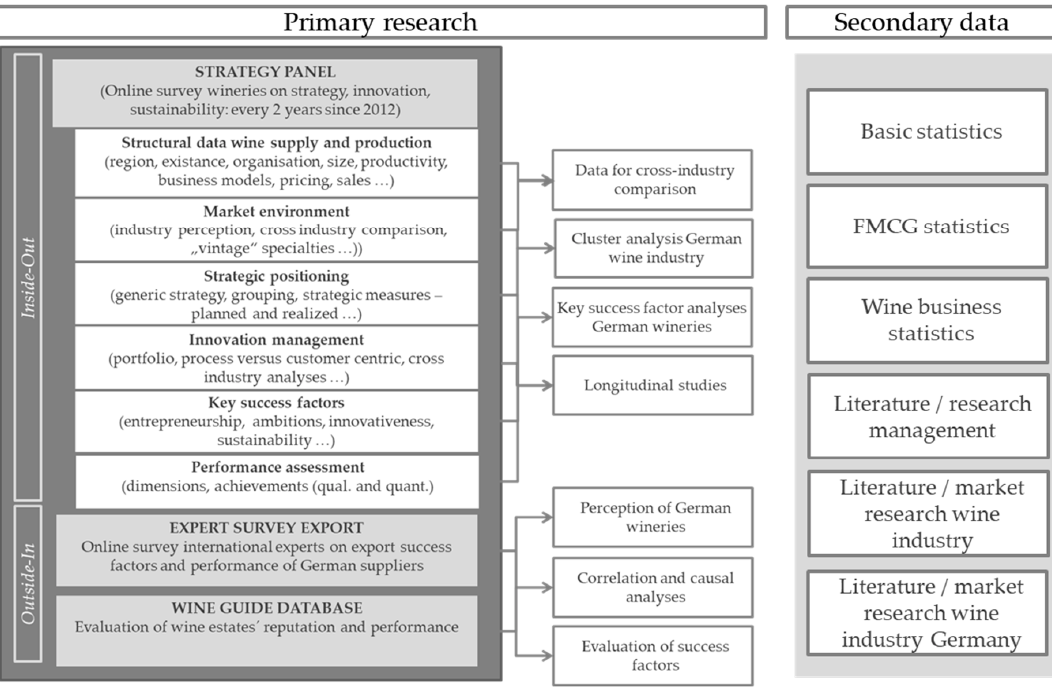
Figure 1. Approach and sources.